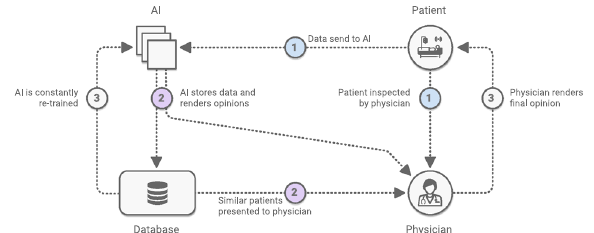
Fig. 5 Clinical Deployment. An example work fl ow showing the positive compounding effect of AI-enhanced work fl ows, and the resultant trust that can be built. AI predictions provide immediate value to physicians, and improve over time as bigger datasets are